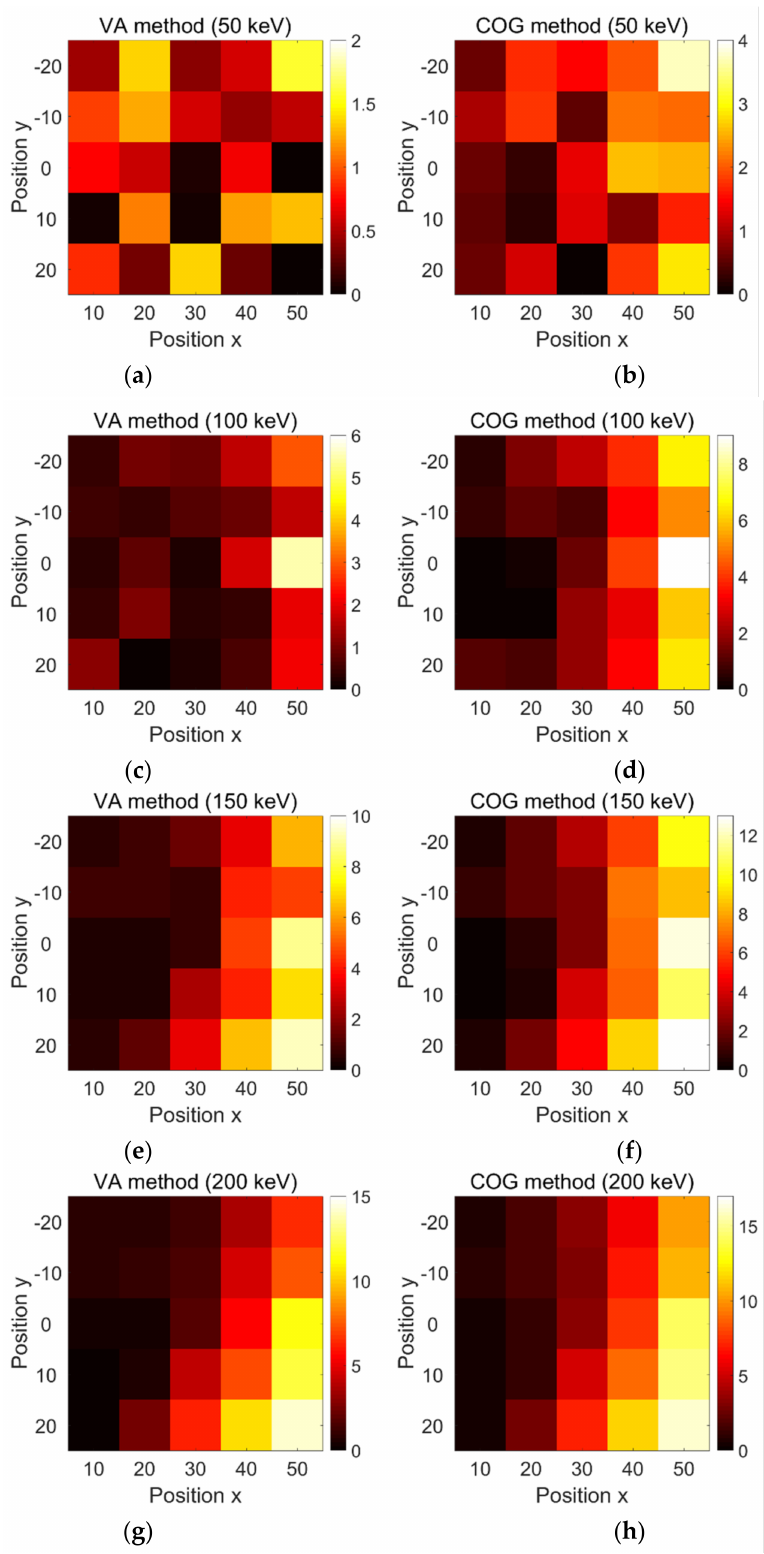
Figure 12. Decoding accuracies obtained by VA method at ( a ) 50 keV, ( c ) 100 keV, ( e ) 150 keV, and ( g ) 200 keV energy window width, as well as using COG method at ( b ) 50 keV, ( d ) 100 keV, ( f ) 150 keV, and ( h ) 200 keV energy window